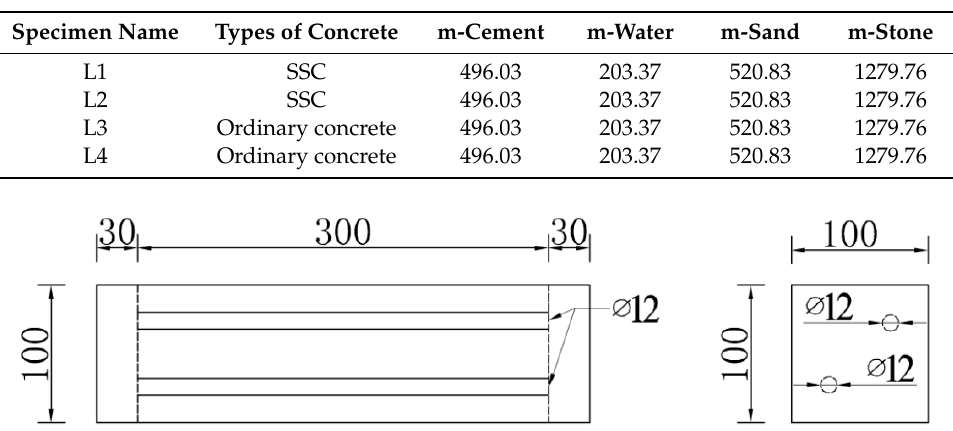
Table 1. Concrete mix proportion (kg/m 3 ).